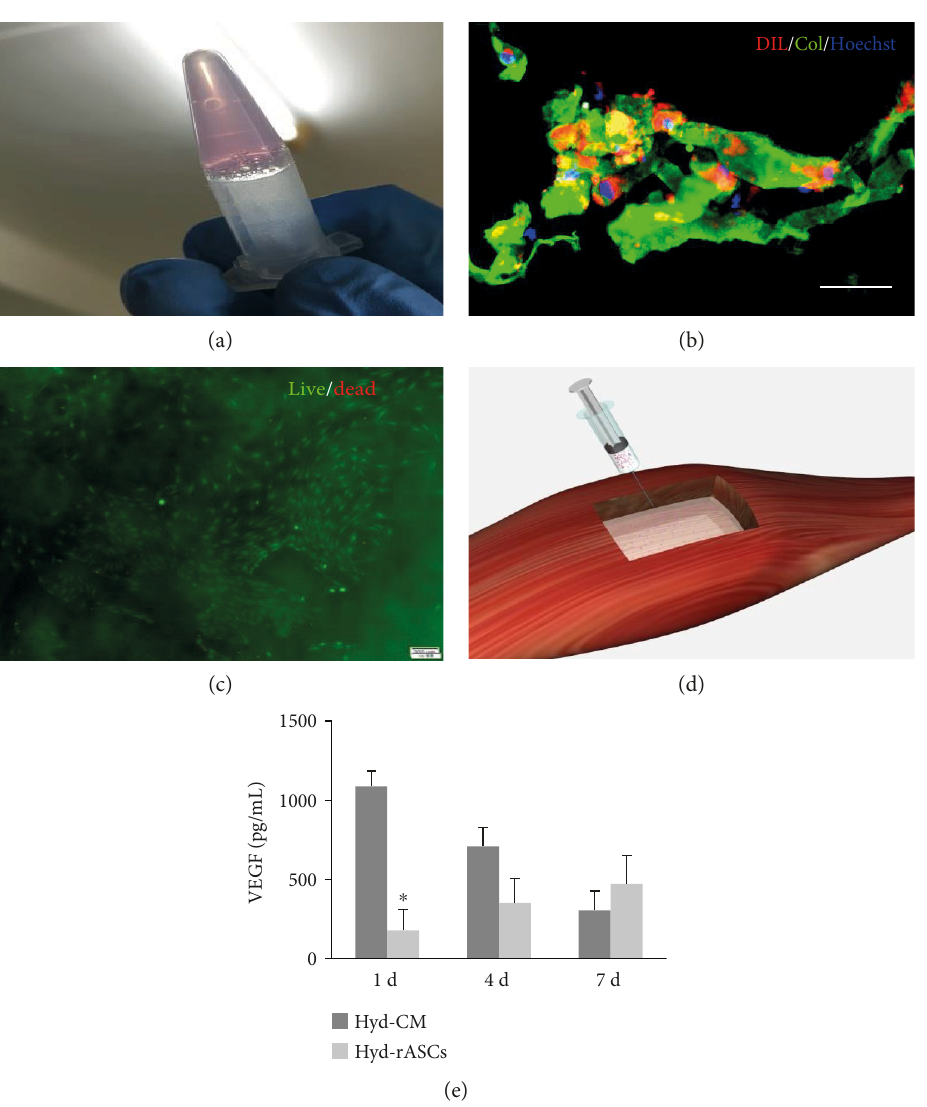
Figure 1: The characterization of injectable hydrogel and rASC viability after seeding. (a) Fabrication of collagen hydrogels. (b) The morphological appearance of CM-Dil-labeled rASCs seeded on collagen hydrogel after 10 days. Scale bar =20 μ m. Green positive represents collagen, red represents CM-Dil-labeled rASCs, and blue represents nuclei. (c) Live/dead cell analysis for ASCs seeded on collagen sca ff olds after 10d seeding. Image displays live cells (green) and dead cells (red). Scale bar =200 μ m. (d) The schematic picture of transplantation. (e) VEGF release in Hyd-CM and Hyd-ASCs on 1d, 4 d, and 7 d. The experiments were carried out with 4 replicates and data presented as mean ± SD. ∗ p < 0 05 versus Hyd-CM